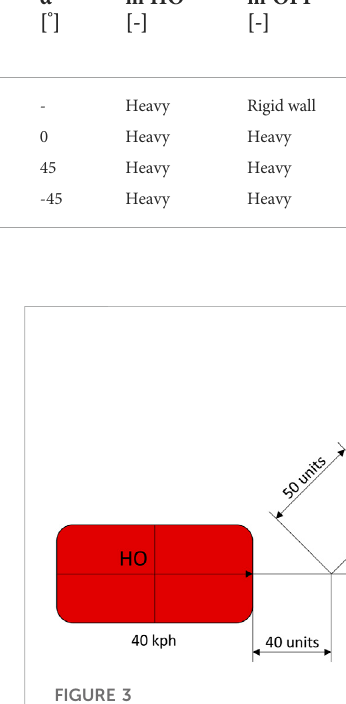
FIGURE 3 Sketch of the Center_45 oblique impact